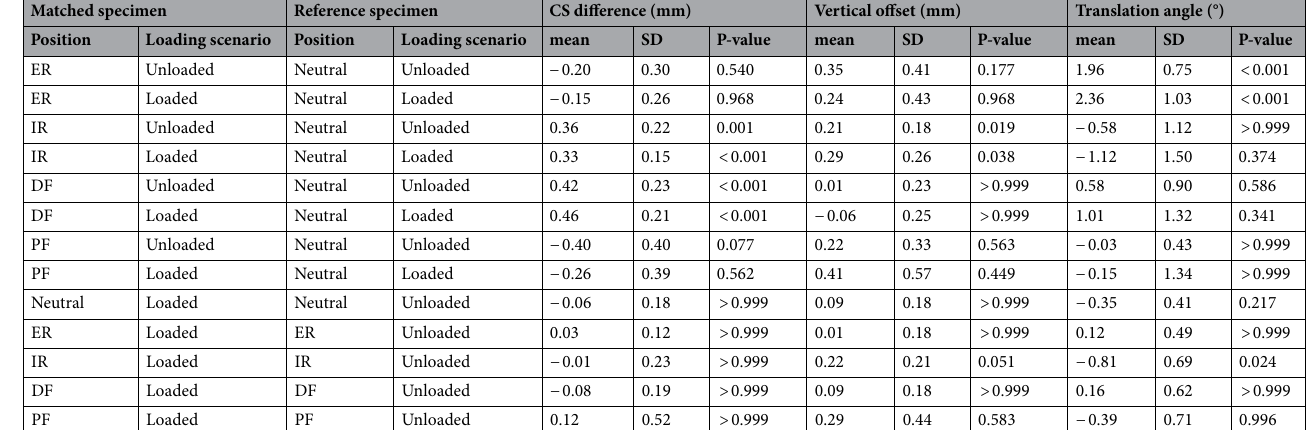
Table 1. Clear space (CS) difference, vertical offset, and translation angle in neutral position, external/internal rotation (ER/IR) and dorsal/plantar flexion (DF/PF), presented in terms of mean value and standard deviation (SD) for different loading scenarios together with the corresponding p-values from statistical